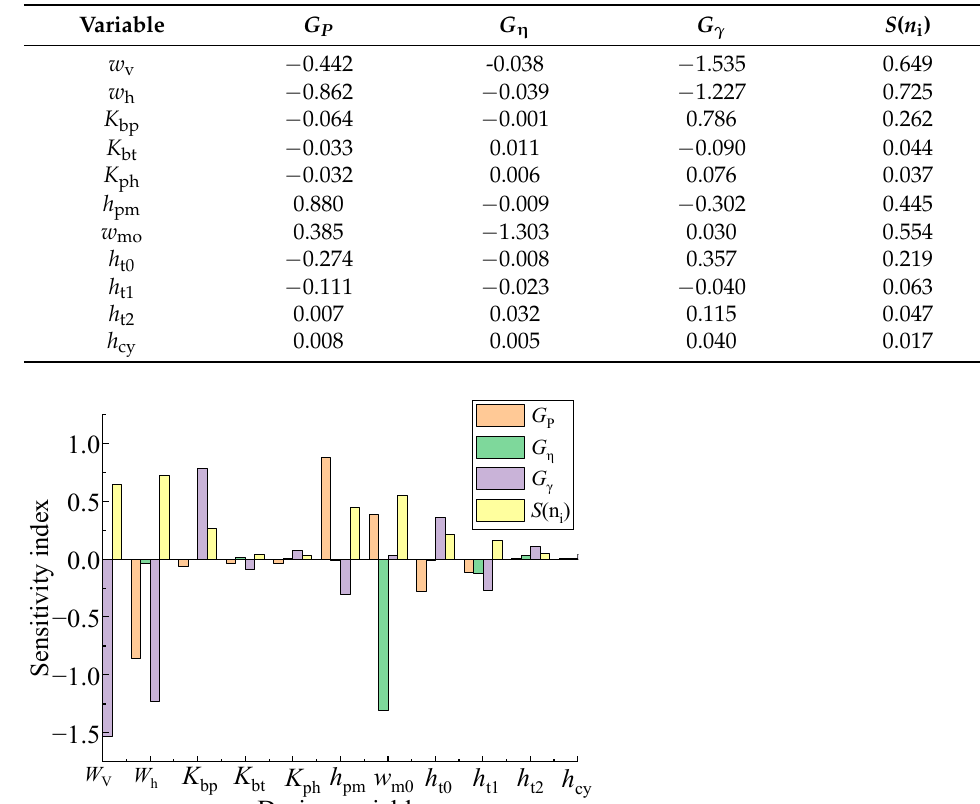
Table 4. Sensitivity values of three design variables.